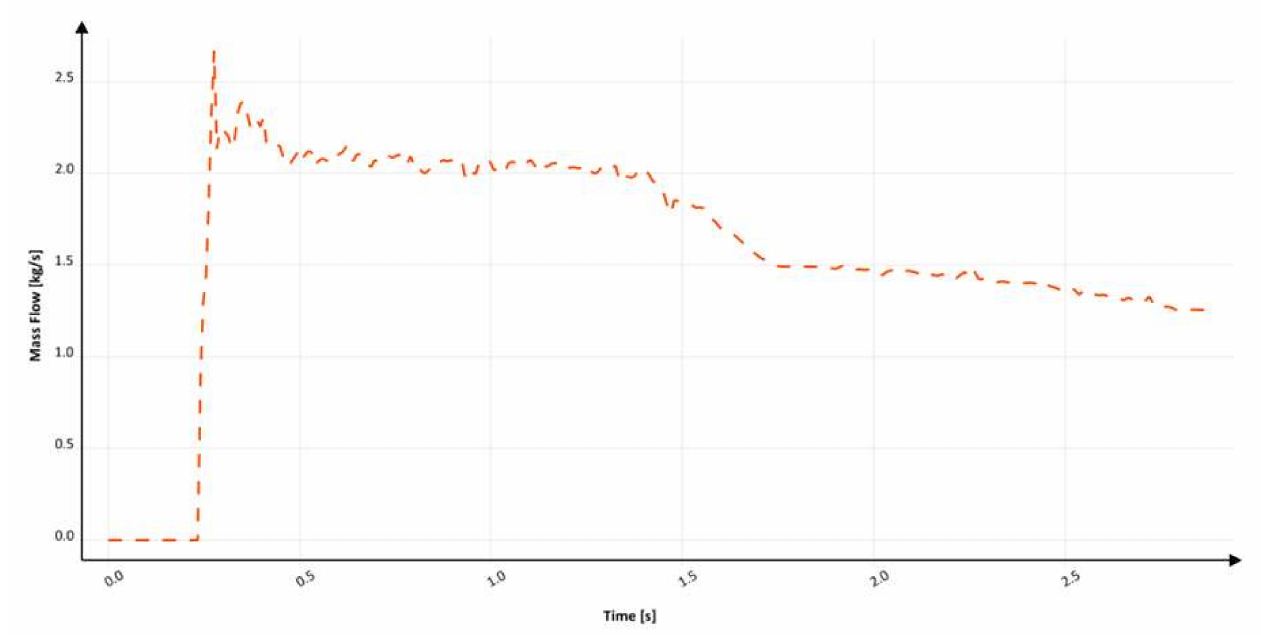
Figure 31. Mass flow through ingate with square sprue with hyperbolic taper (S s 7),